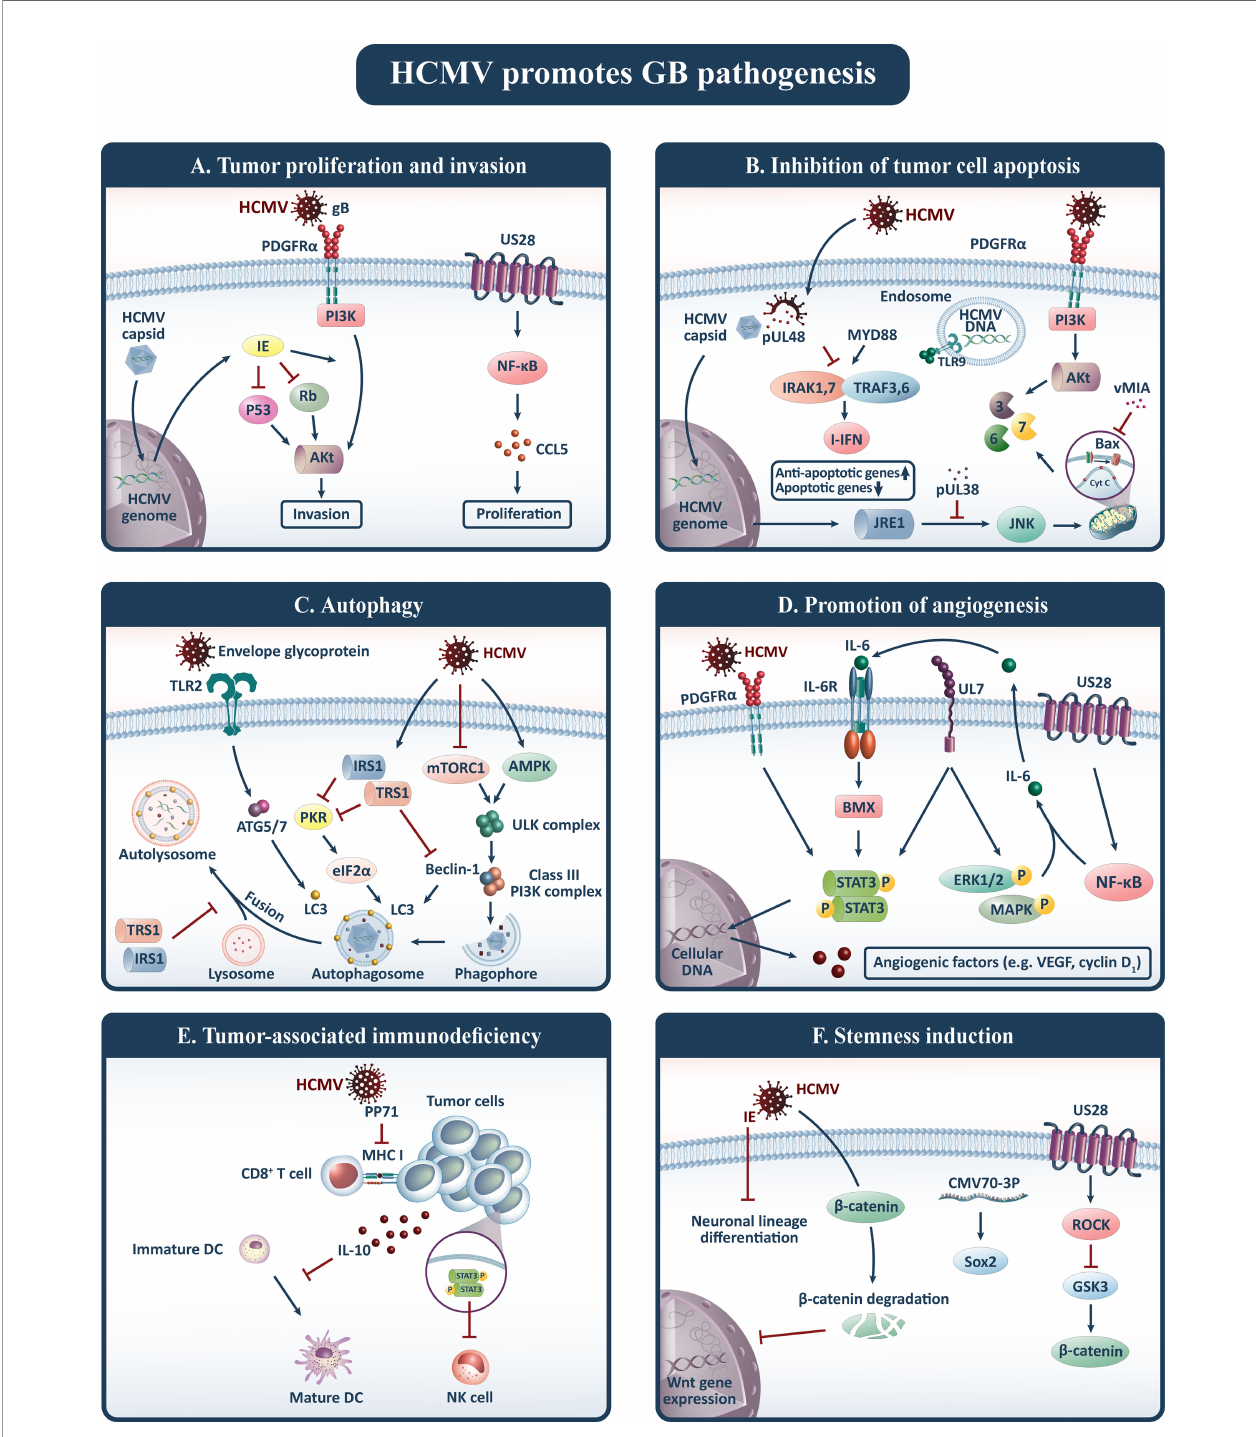
FIGURE 1 | HCMV contributes to gliomagenesis and promotes six oncogenic pathways including: (A) tumor proliferation and invasion, (B) inhibition of tumor cell apoptosis, (C) autophagy, (D) promotion of angiogenesis, (E) tumor-associated immunode fi ciency, and (F) stemness induction. Akt, Protein kinase B; CCL5, Chemokine (C-C motif) ligand 5; DC, Dendritic cell; HCMV, Human cytomegalovirus; IE, Immediate-early protein; I-IFN, type I interferon (I-IFN); IL, Interleukin; JNK, c- Jun N-terminal kinase; LC3, Light chain 3; MHC, Major histocompatibility complex; NF- k B, Nuclear factor-kappa B; NK, Natural killer; PDGFR a , Platelet-derived growth factor receptor alpha; PI3K, Phosphatidylinositol-3-kinase; Rb, Retinoblastoma; SOX2, SRY-Box 2; STAT3, Signal transducer and activator of transcription 3; TLRs, Toll-like receptors; TRAF3, TNF receptor-associated factor; Treg, Regulatory T cell; VEGF, Vascular endothelial growth factor; vMIA, viral mitochondria- localized inhibitor of